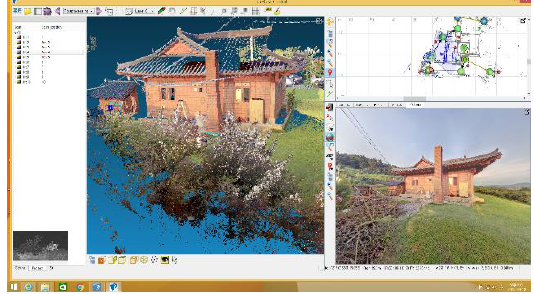
Figure 6. 3D model generated at Station 1 and photo image